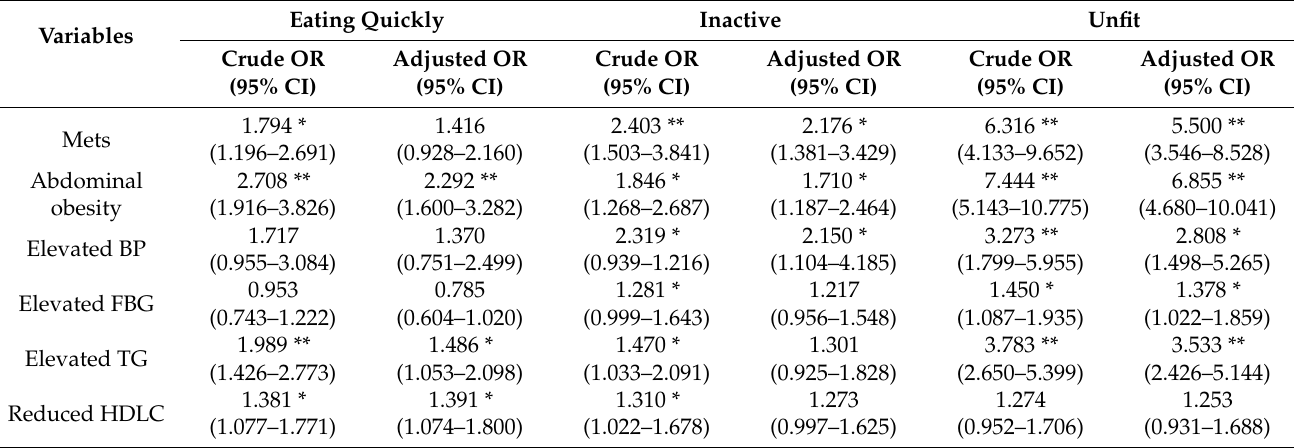
Table 3. Odds ratios and 95% confidence intervals for metabolic syndrome and its components according to risk factors in univariate logistic